Question: Compose a caption that would accompany this figure in a paper.
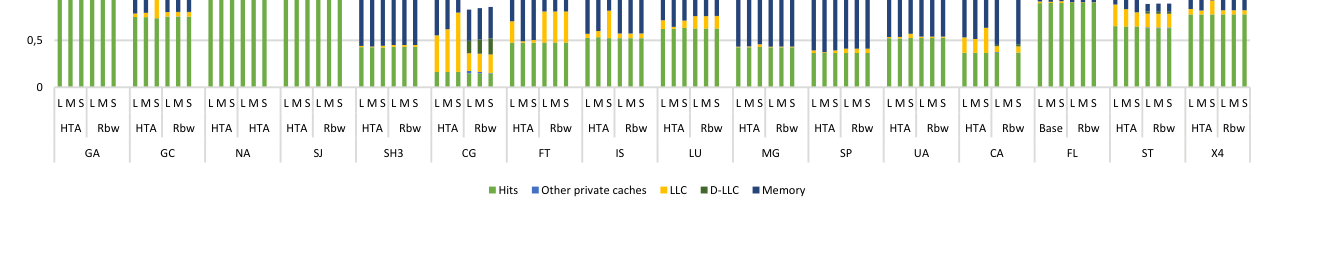
Answer: Large-size normalized memory latency in a 4-CMP system.(large: 131k; medium: 16k; small: 4k) and LLC (full:4MB per CMP, half: 2MB  per CMP) in a 4-CMP system.